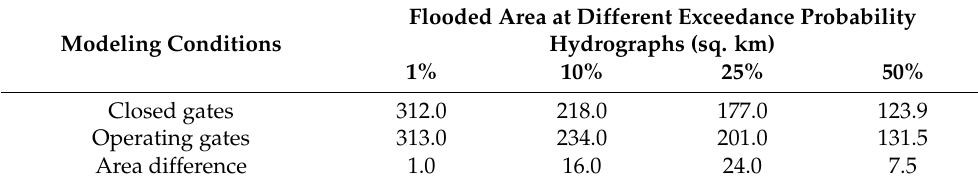
Table 2. Flood inundation areas at different